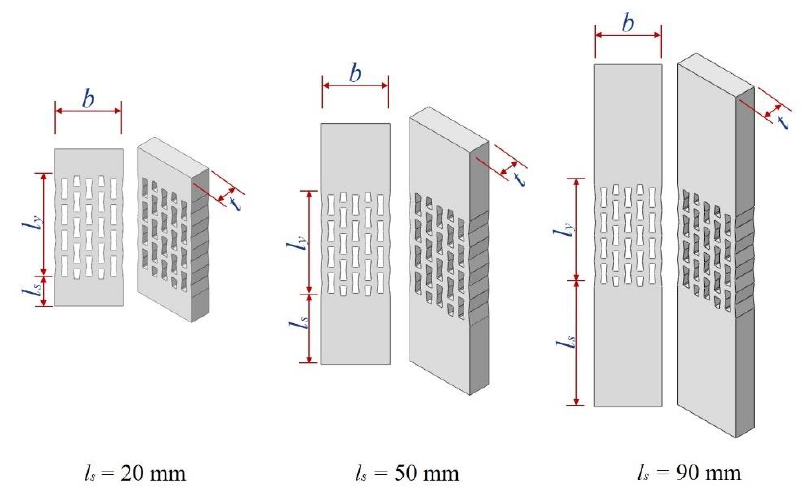
Figure 22. H40A85R0.5 specimens with different lengths of solid area.